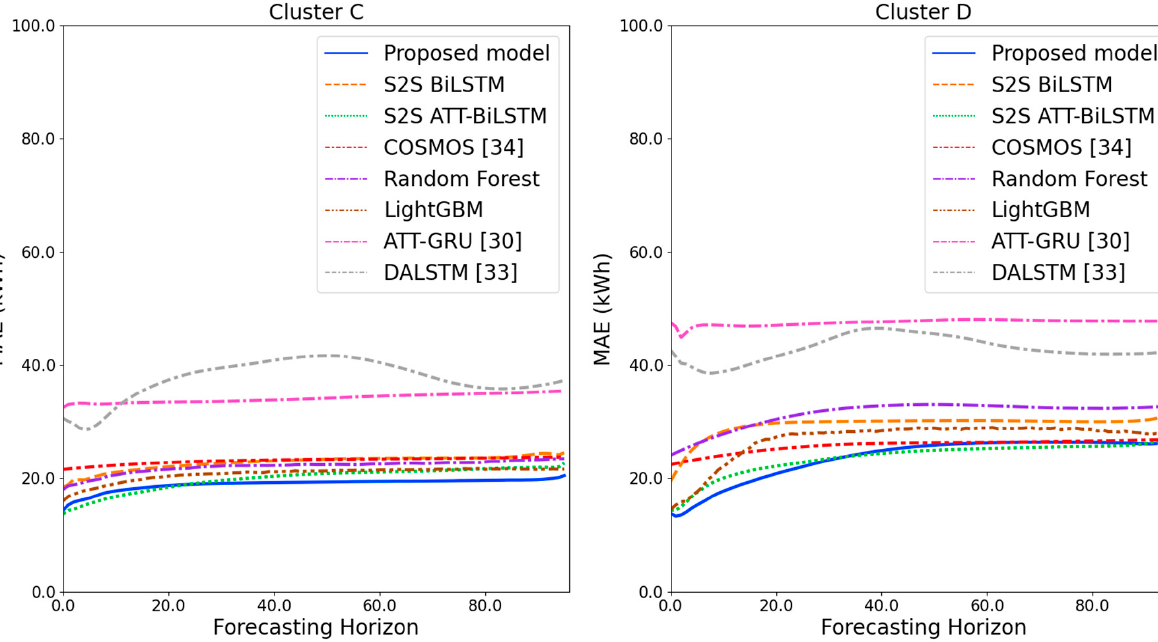
Figure 16. MAE results of clusters C and D over the entire forecasting horizon (kWh).